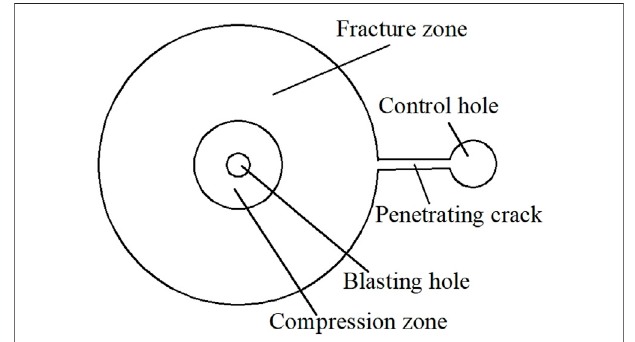
FIGURE 1 | Schematic diagram of controlled blasting.